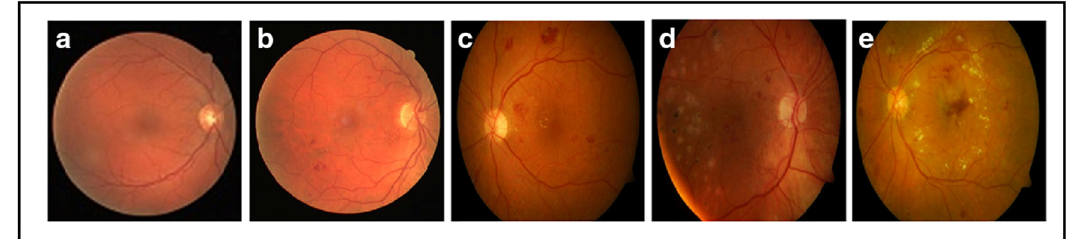
Figure 10: Images from the APTOS 2019 dataset. ( a ) Normal image, ( b ) mild DR, ( c ) moderate DR, ( d ) severe DR, and ( e ) proliferative DR.